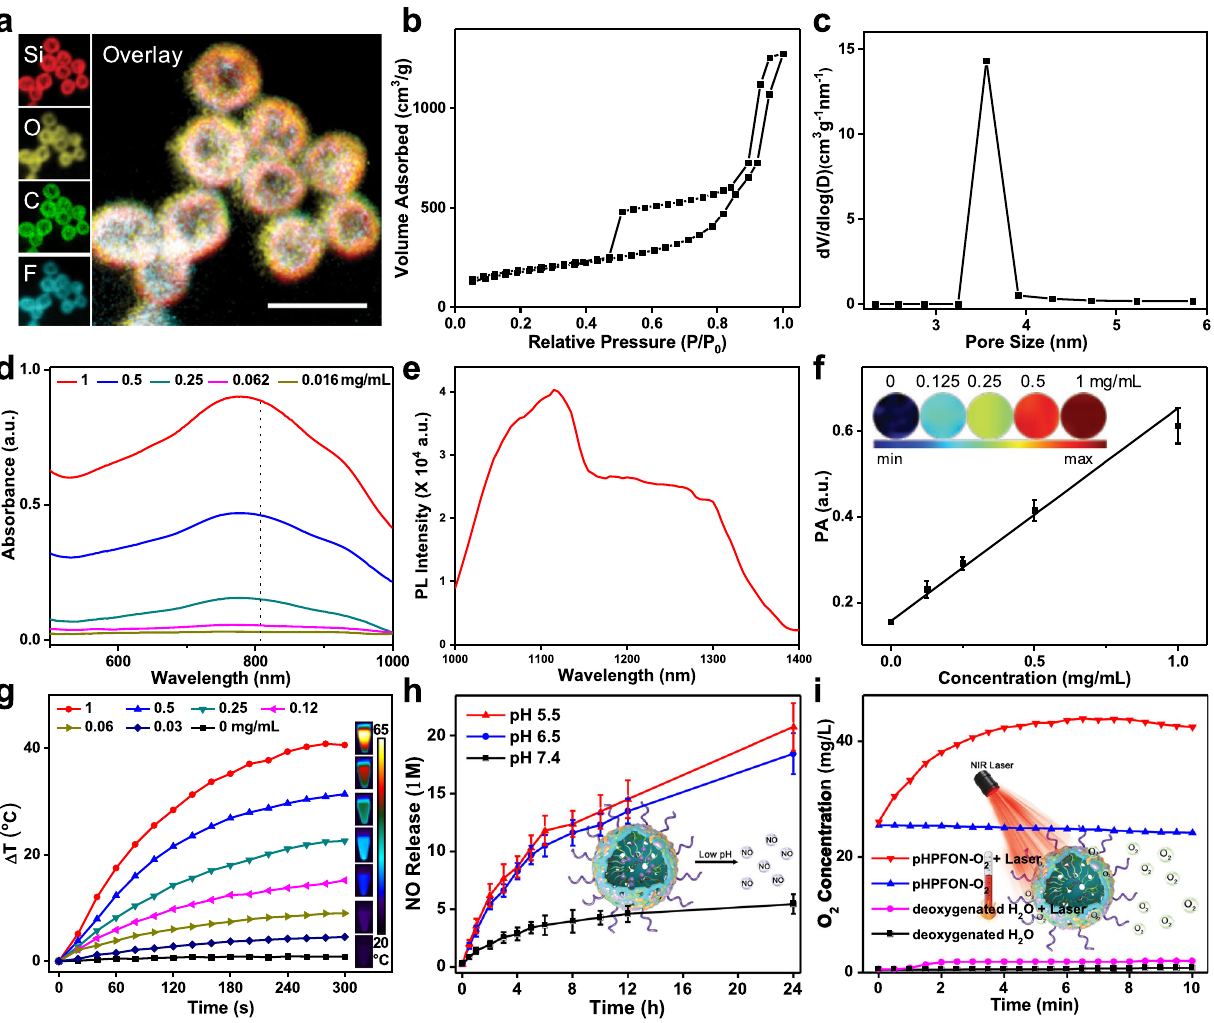
Fig. 3 Characterization of pHPFON nanoplatform. a Elemental mapping. Scale bar, 50 nm. b N 2 adsorption – desorption isotherm and c corresponding pore-size distribution. d UV – vis spectra of pHPFON at various concentrations. e NIR-II fl uorescence spectrum. f Plot of PA signal versus concentration. Inset: PA images at concentrations ranging from 0 to 1 mg/mL. g Photothermal heating curves and images of pHPFON at different concentration under 808-nm laser irradiation at 1 W/cm 2 . h Cumulative NO release from pHPFON-NO at different pH values. Inset: schematic illustration of